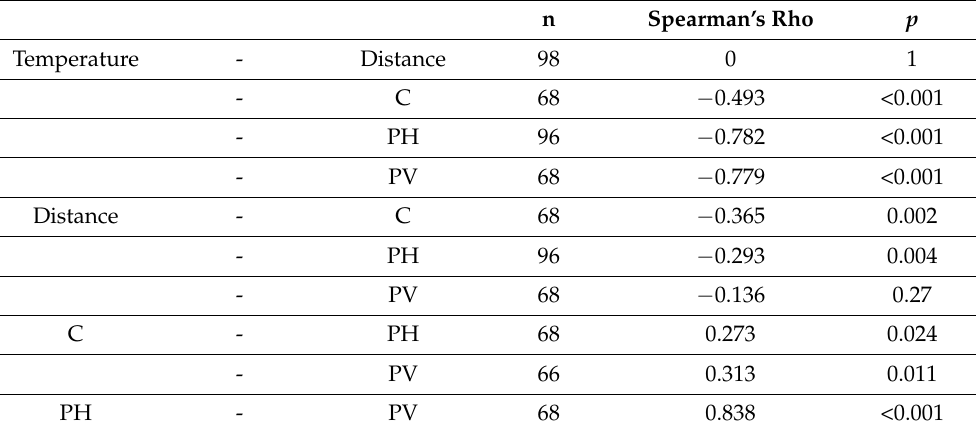
Table 4. Correlation analysis using